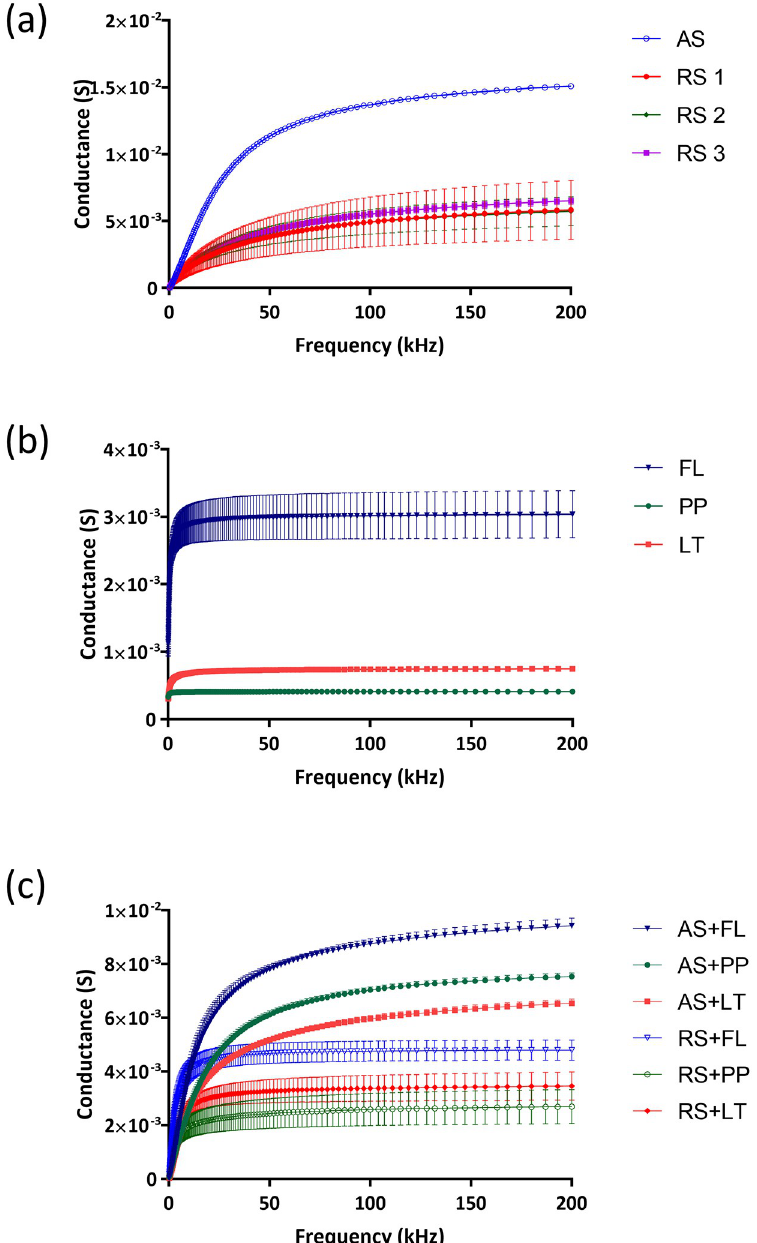
Fig 4. Conductance values of (a) real saliva from three healthy subjects (RS1, RS2, RS3) and artificial saliva (AS), (b) chlorhexidine (PP)-, fluoride (FL)- and essential oil (LT)-based mouthwashes, and (c) mixed liquids with real saliva and artificial